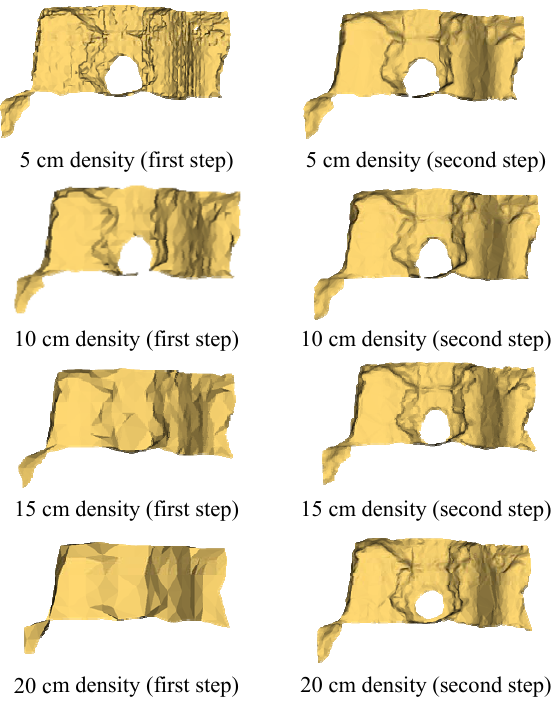
Figure 4a: 2 steps mesh algorithm